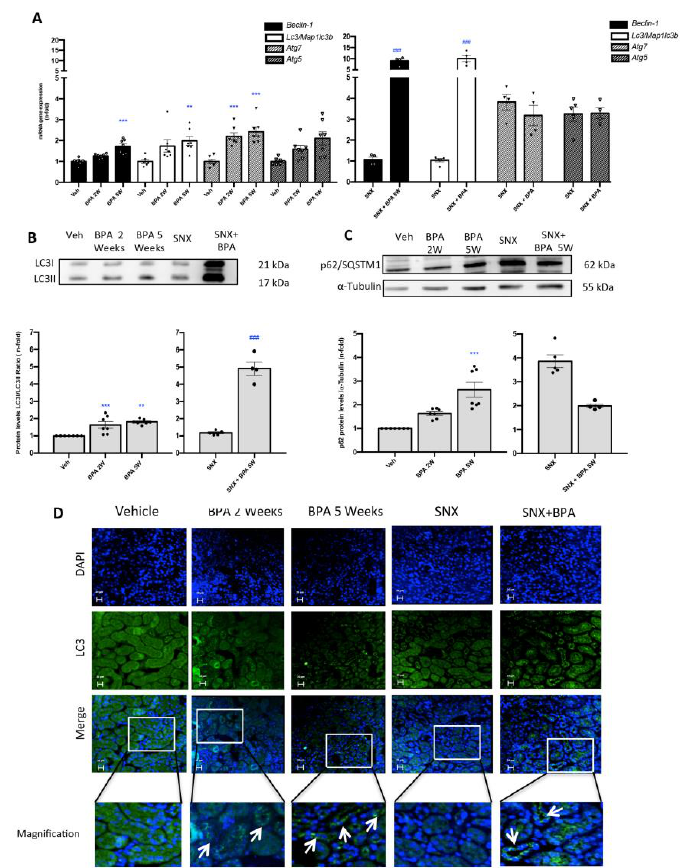
Figure 5. Systemic chronic administration of BPA blocks autophagosome maturation in experimental SNX model . Animals were intraperitoneal injected with 120 mg/kg/day BPA (5 days a week) or vehicle (corn oil) and sacrificed after 2 or 5 weeks. Some animals were subjected to subtotal nephrectomy (SNX), then treated or not with BPA and sacrificed after 5 weeks. ( A ) Beclin-1 , Atg5, Atg7, Map1lc3b/Lc3b mRNA levels were assessed by RT-PCR in renal tissue. ( B , C ) Representative Western blot and quantification of protein levels of LC3II/I ratio and p62/SQSTM1 in renal tissue lysates. All data are presented as the mean ± SEM of 4–7 mice per group, ** p < 0.01; *** p < 0.001 vs. Vehicle, ### p < 0.001 vs. SNX. ( D ) Immunofluorescence staining localized LC3 expression in renal tubules in all groups with exposure to BPA. Magnification 200 × ; scale bar represents 20 µ m (arrows identify LC3B cytoplasmic staining). Comparison between SNX and SNX + BPA groups was performed using a parametric unpaired two-sided t test. The analysis of WT vs. BPA-treated groups was done by one-way ANOVA, followed by the Tukey HSD multiple comparison